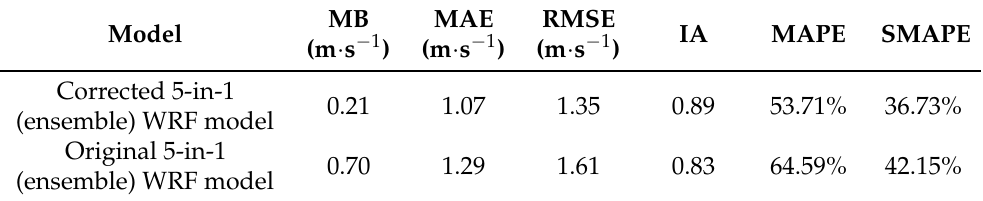
Table 6. Evaluation results for the wind speed forecasting using the corrected and original 5-in-1 (ensemble) WRF models applied to the 4-day test